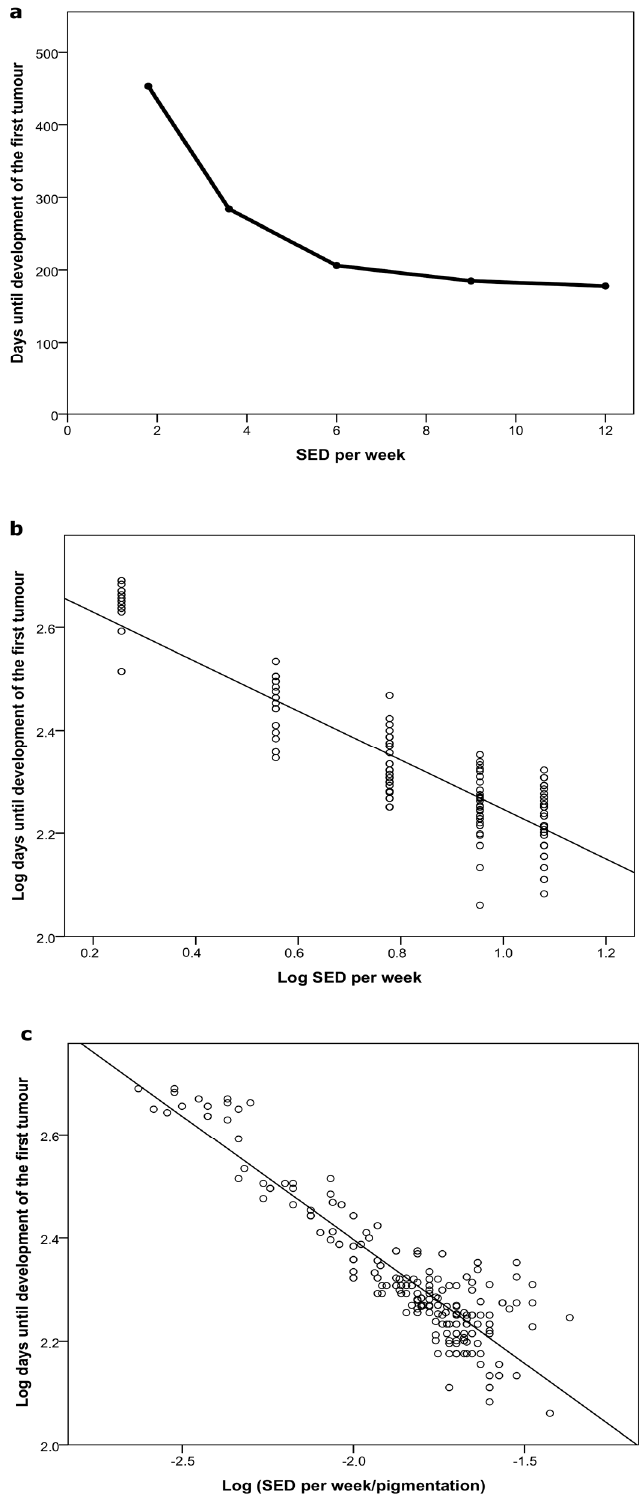
Figure 4. Dose–response curves (Groups 6–10) ( a ) Standard erythema doses (SED) per week as a function of median days until development of the first tumor; ( b ) Log 10 SED per week as a function of log 10 median days until development of the first tumor (y = − 0.48X + 2.72, R 2 = 0.802); ( c ) Log 10 (SED per week/pigmentation) as a function of log median days until development of the first tumor (y = − 0.48X + 1.44, R 2 = 0.826).